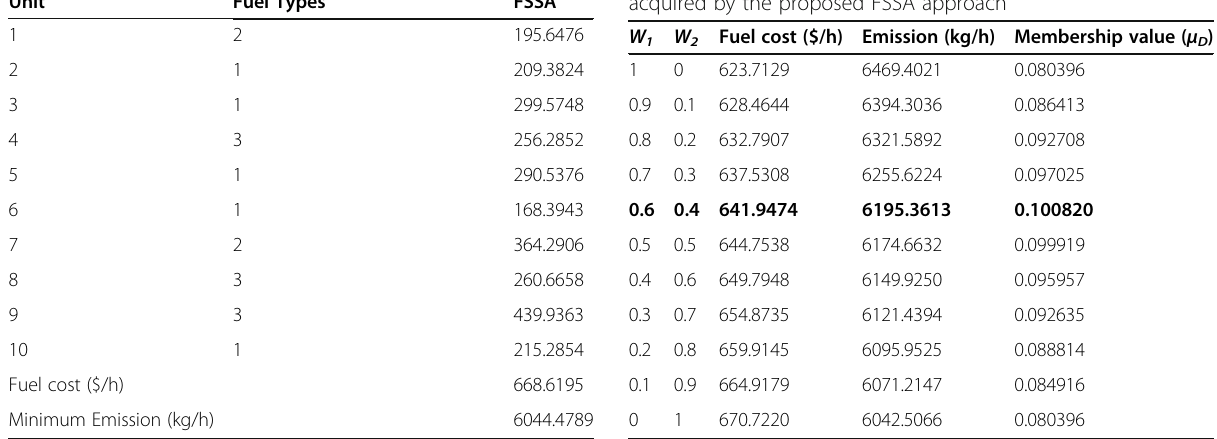
Table 3 Optimal solution acquired by the FSSA approach for emission objective Unit